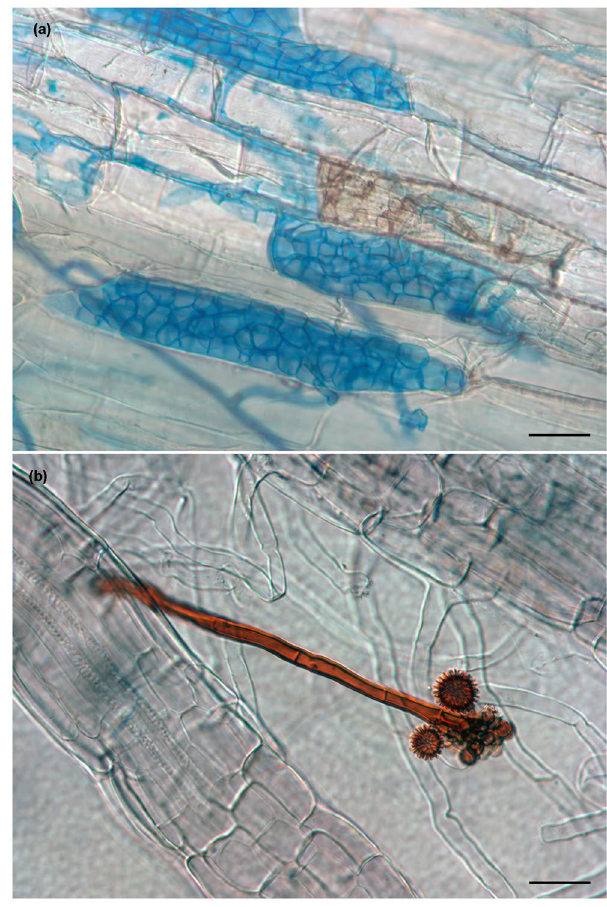
Figure 1. Characteristic structures of Cadophora sp. and Periconia macrospinosa in an artificial inoculation system with Zea mays . ( a ) Intra- and intercellular septate hyphae and microsclerotia of Cadophora sp. are visualized after staining with aniline blue. Intracellular pigmented hyphal structures in the root can also be seen. ( b ) P. macrospinosa colonization of roots with barely stainable hyphae. Its pigmented conidiophore can be seen with characteristic spiny conidia. Scale bars 30 µ